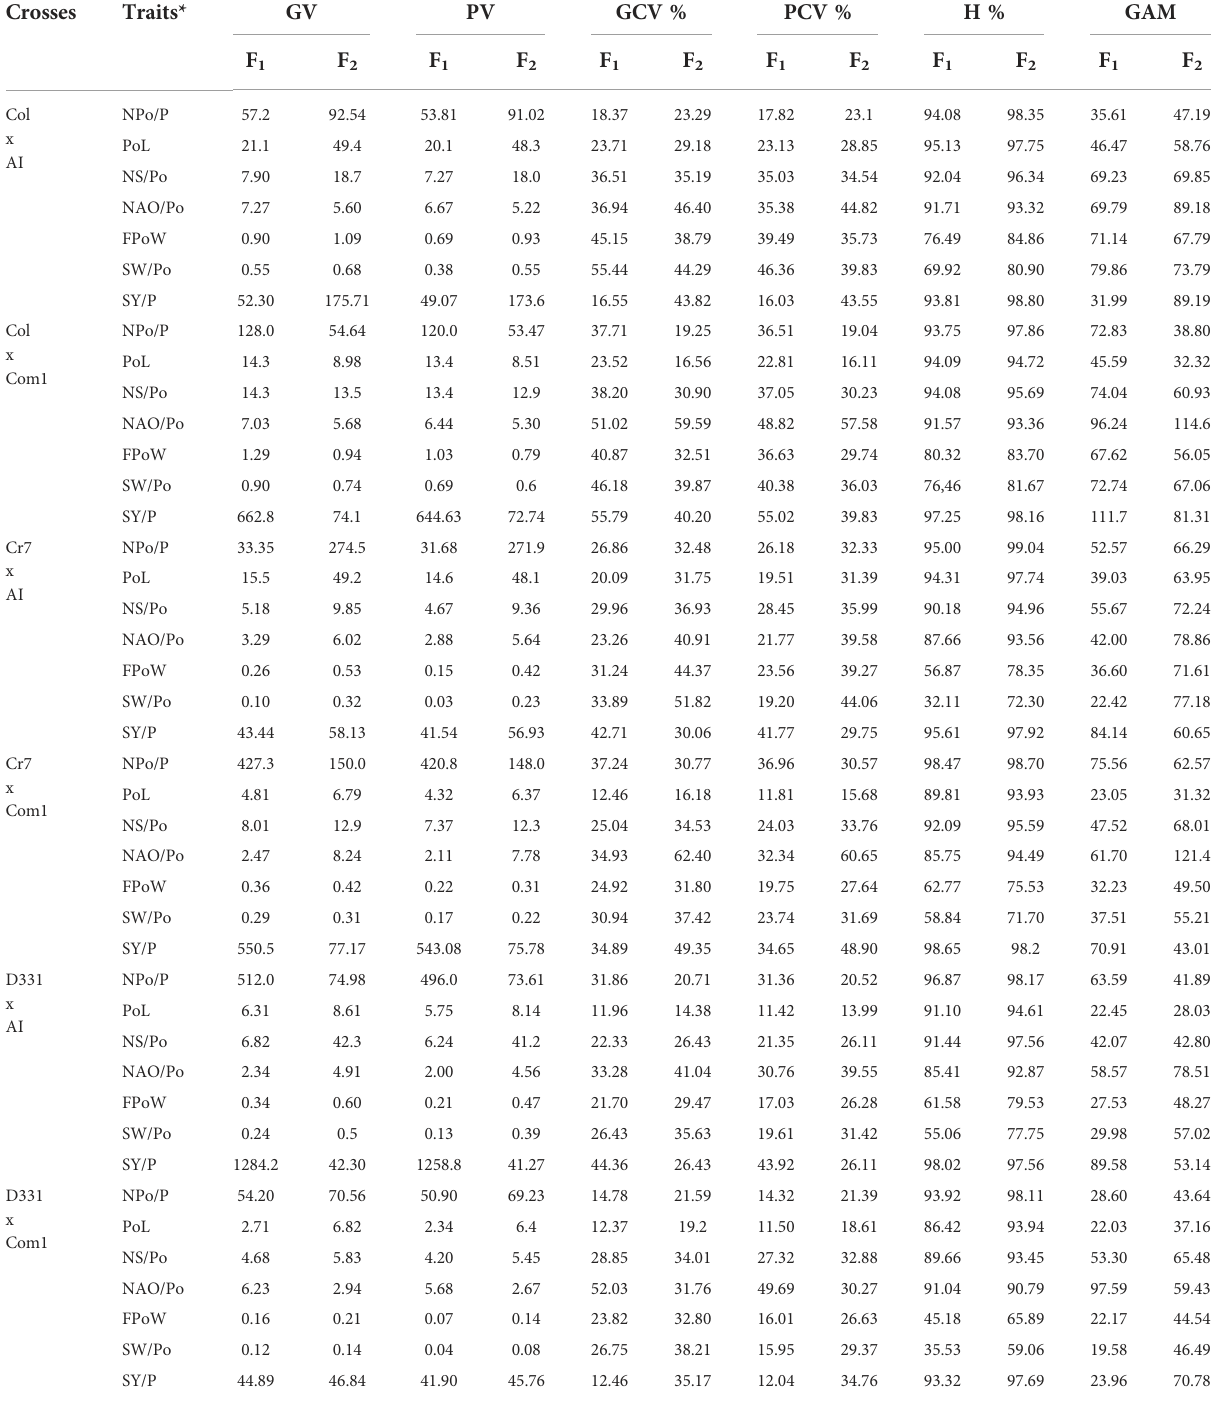
TABLE 6 Genotypic variance (GV), phenotypic variance (PV), genotypic coef fi cient of variance (GCV %), phenotypic coef fi cient of variance (PCV %), heritability (H%), and genetic advance mean (GAM) of pods, seeds traits and yield of the six crosses in F 1 and F 2 produced from crossing